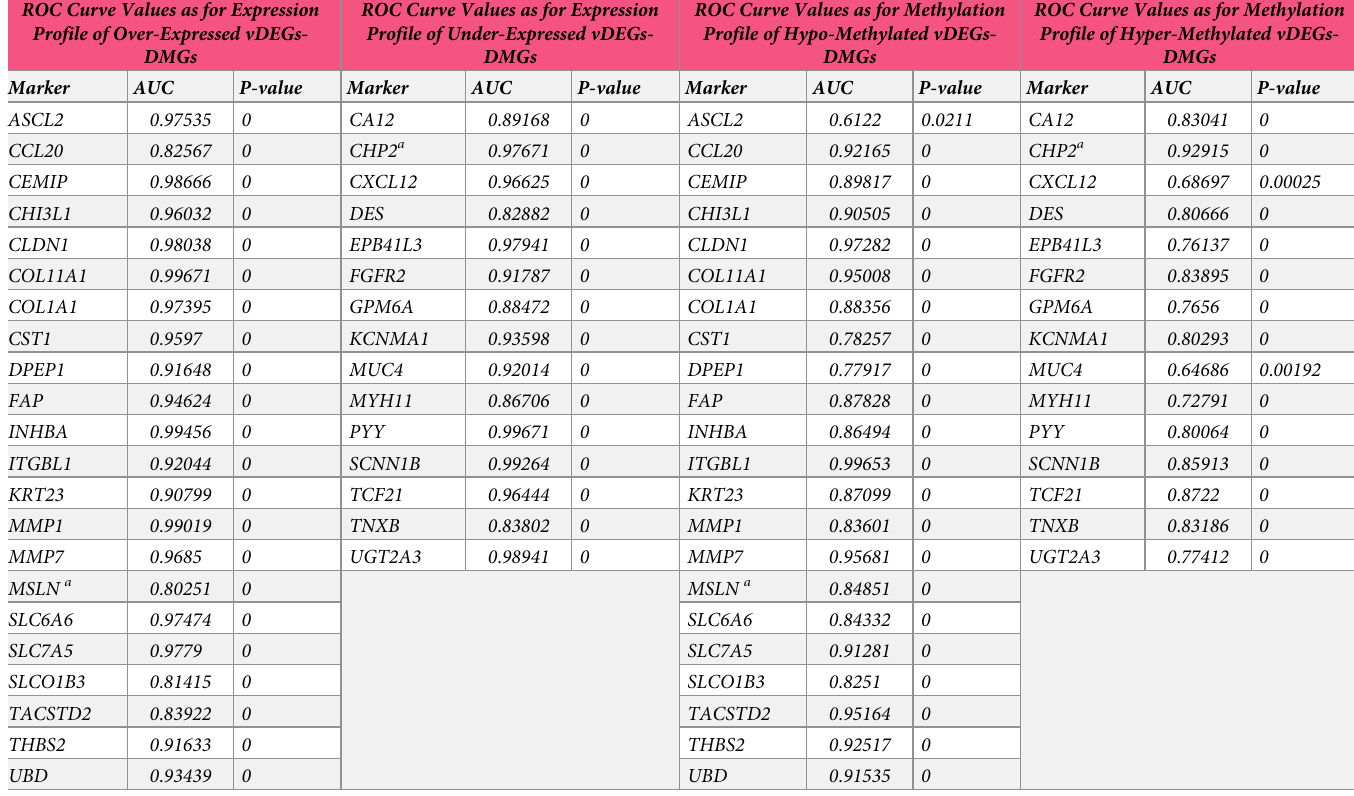
Table 3. The area under curves as for vDEGs-DMGs to the accompaniment of their statistically significance. ROC Curve Values as for Expression ROC Curve Values as for Expression ROC Curve Values as for Methylation ROC Curve Values as for Methylation Profile of Over-Expressed vDEGs- Profile of Under-Expressed vDEGs- Profile of Hypo-Methylated vDEGs- Profile of Hyper-Methylated vDEGs- DMGs DMGs DMGs